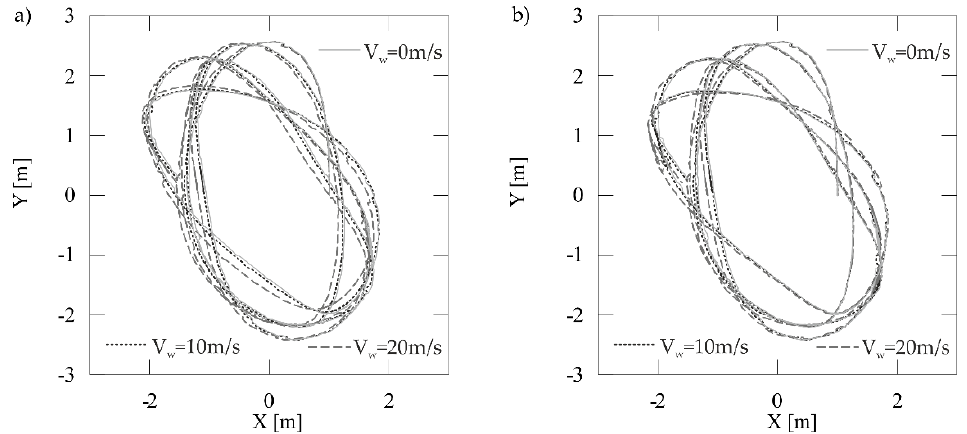
Figure 15. Projection of the trajectory of the carried load’s suspension point on the rotation plane for ( a ) the variable effective area and ( b ) fixed effective area.